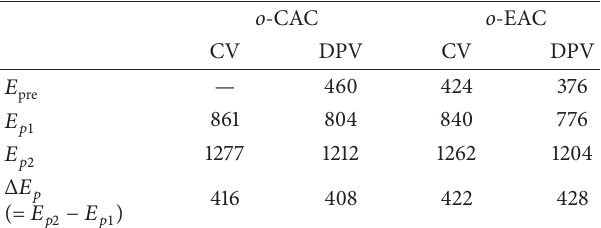
Table 1: Anodic peak potentials of o -CAC and o